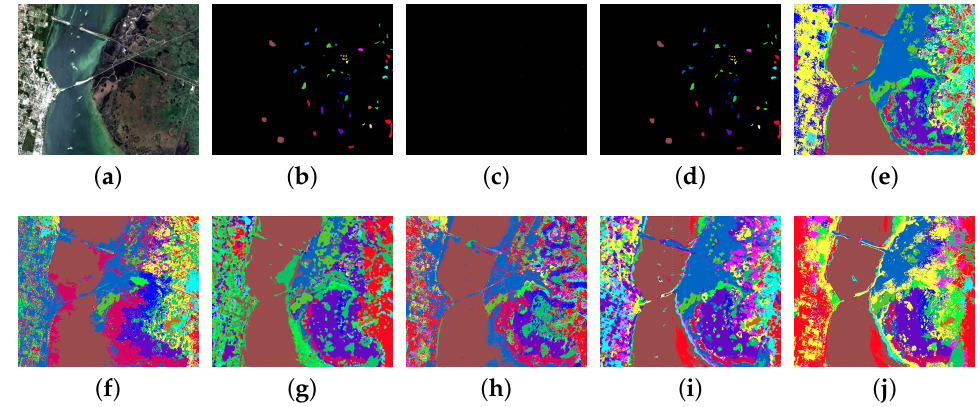
Figure 8. Classification maps of different methods on the KSC data set. ( a ) False Colour Image; ( b ) Ground Truth; ( c ) Training set ( d ) Test set; ( e ) LCMR; ( f ) SCMK; ( g ) CEGCN; ( h ) PRNet; ( i ) LCEM; ( j ) SPCM.